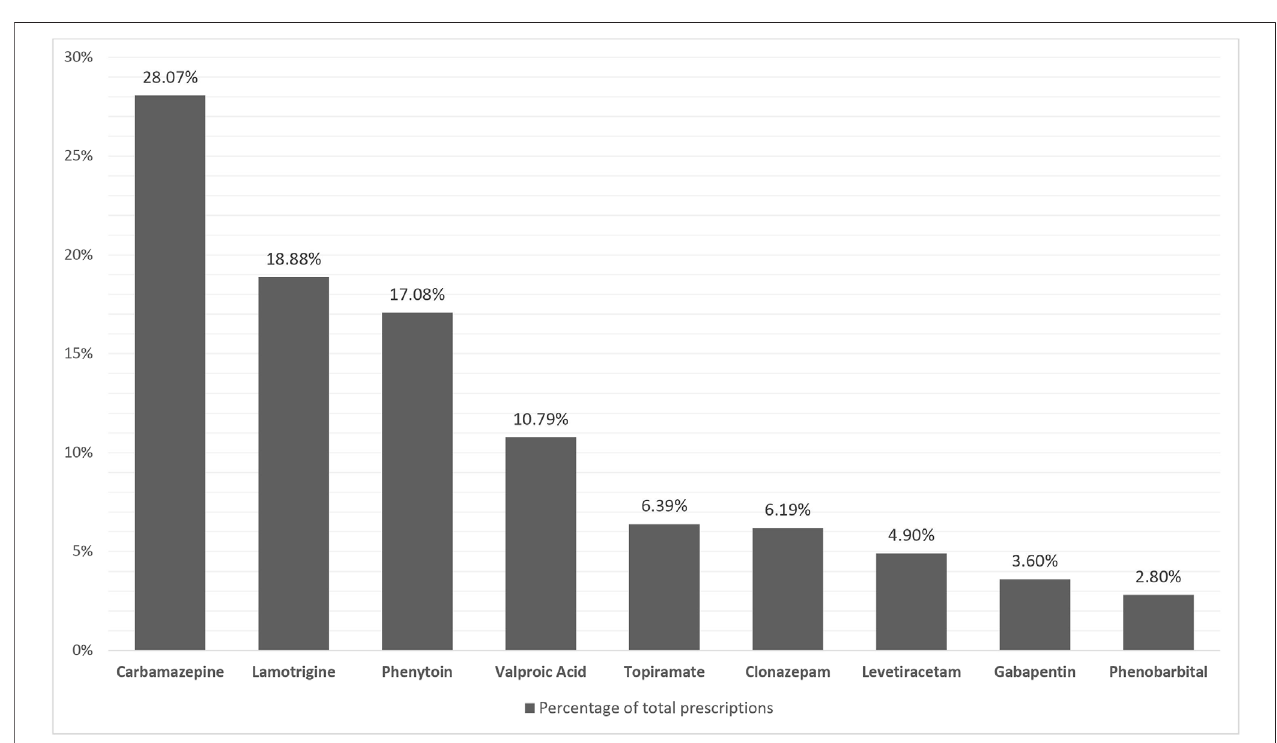
FIGURE 3 | Most used ASMs among pregnant women with epilepsy.